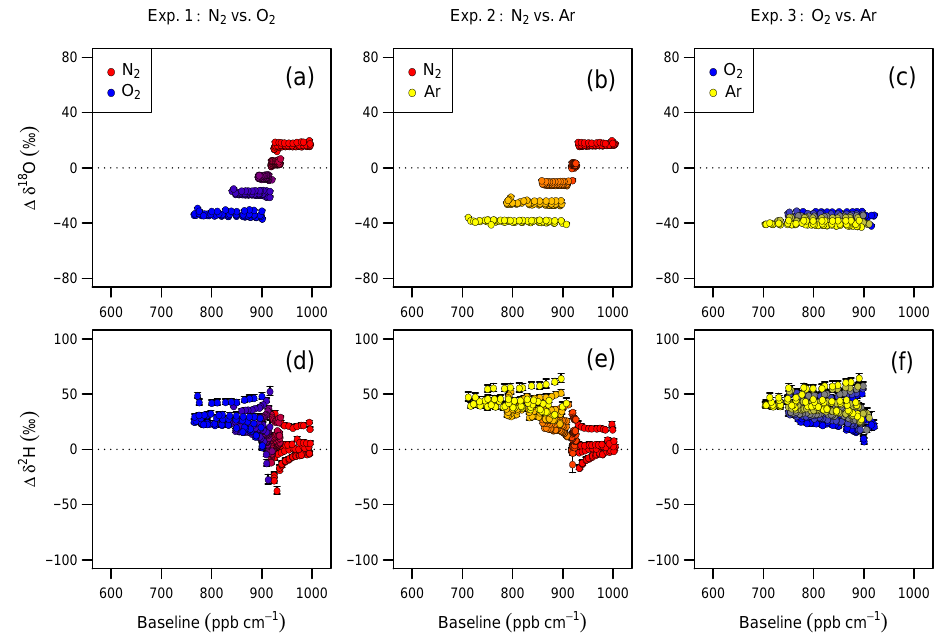
Figure 4. Relationship between the spectral baseline, (cid:49)δ 18 O, and (cid:49)δ 2 H values. For each panel, n = 330 measurements of four liquid standards across a range of injection volumes (i.e., 400–2400nL, in 11 steps of 200nL each). Points represent mean values ± SD for replicates of each standard at each injection